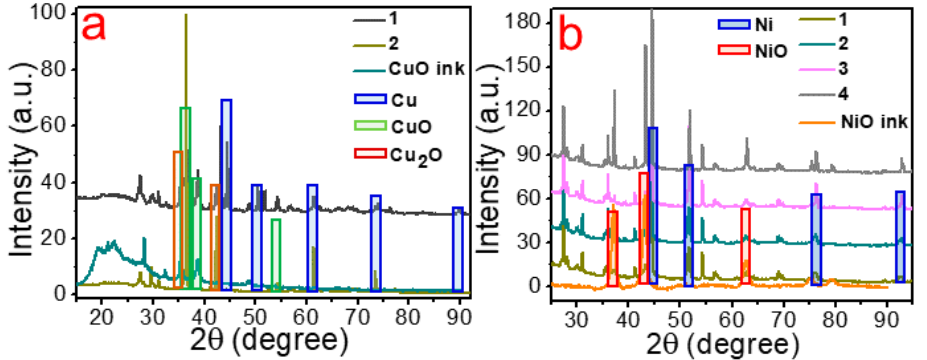
Figure 4. XRD patterns of ( a ) Cu (samples 1, 2 and initial mixture (CuO ink) are shown in the legend) on glass-ceramics and ( b ) Ni (samples 1–4 and initial mixture (NiO ink) are shown in the legend) on glass-ceramics sintered at the following laser fluence (J/cm 2 ), scanning speed (mm s − 1 ) and pitch size ( µ m): 0.0192, 5, 5 for 1; 0.0154, 5, 5 for 2; 0.0192, 10, 5 for 3; 0.0154, 10, 5 for